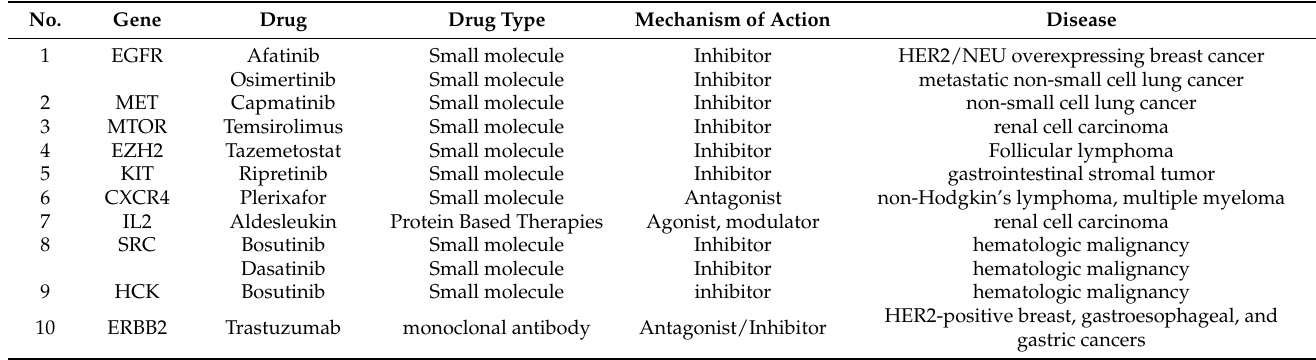
Table 1. List of approved drugs for candidate hub genes based on TTD database, DrugBank database, PubChem, ClinicalTrials.gov, and Drugs@FDA: FDA-Approved